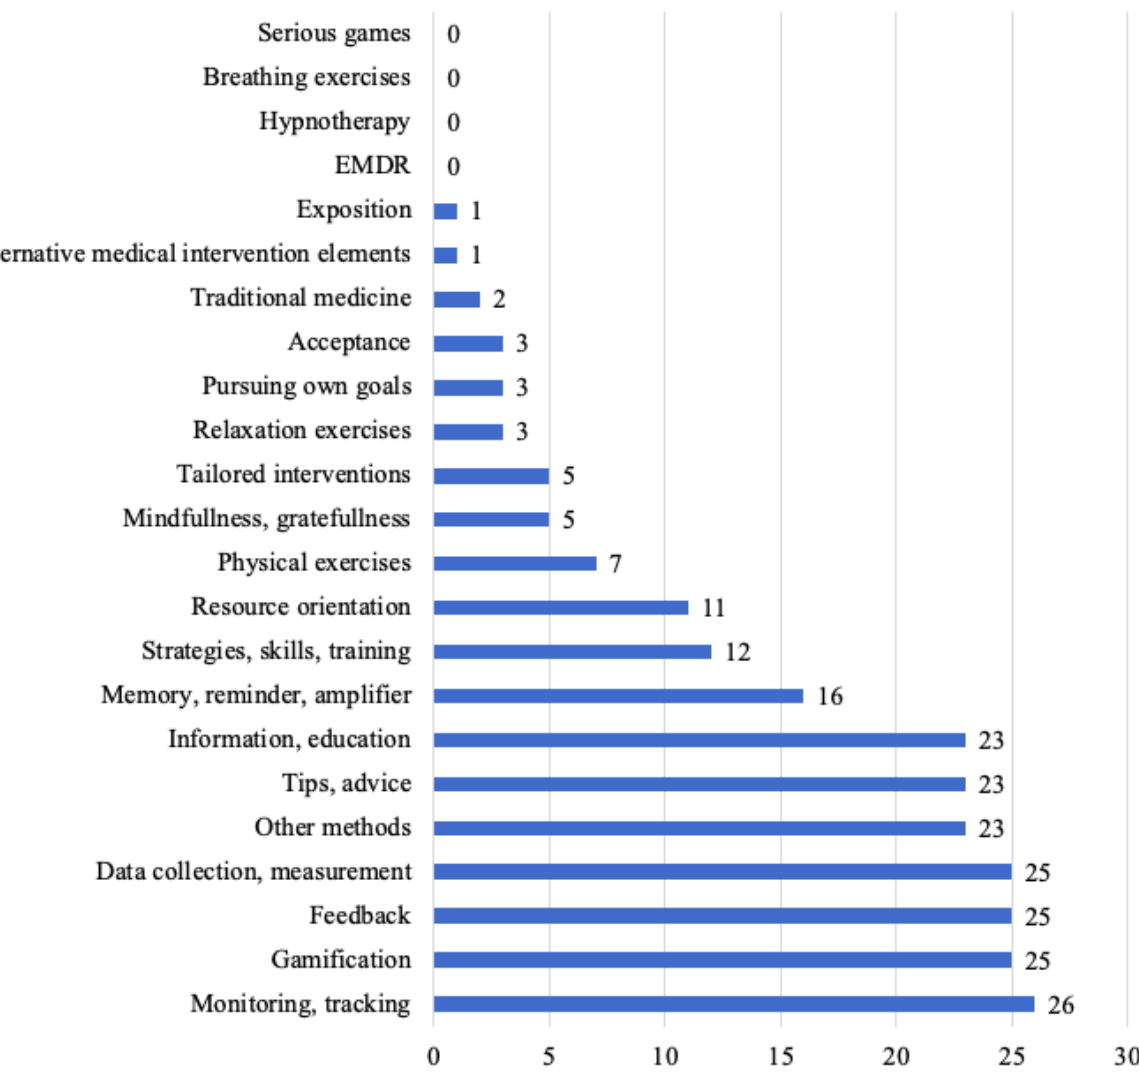
Figure 3. Frequency of methods used in mobile apps for older adults. Multiple naming of different methods in one mobile app was possible. Data are given for n=83 mobile